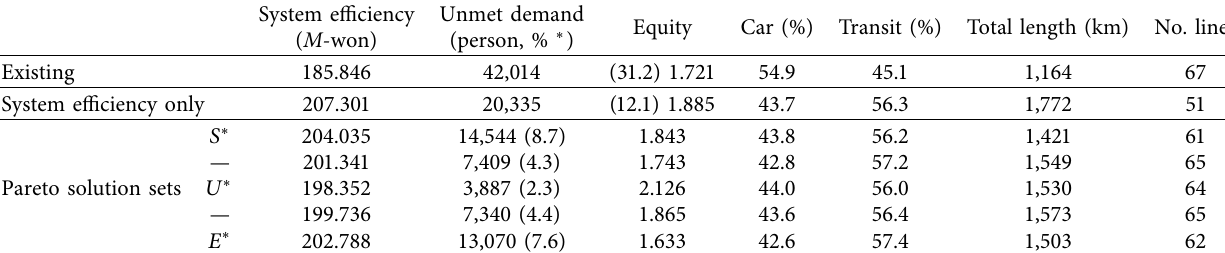
Table 6: Summary of the solutions for the transit networks.